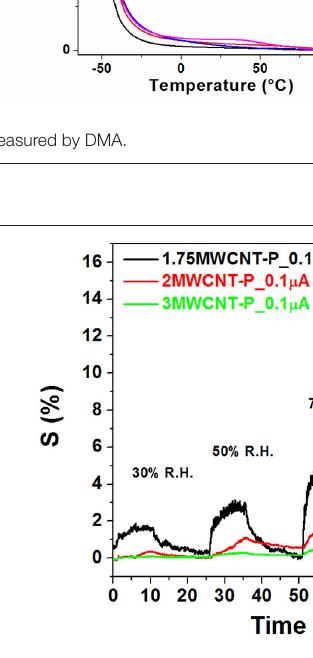
0.3mm thick SEBS-MA-PEG/MWCNT-P ∼